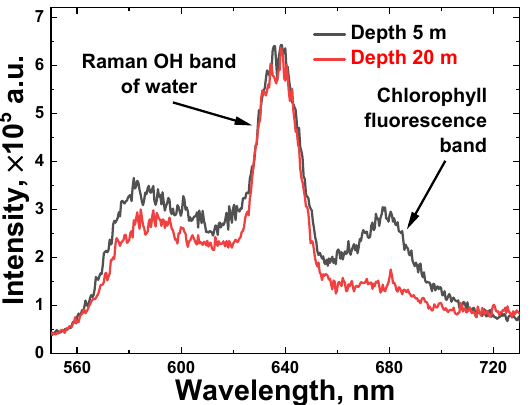
Figure 4. Onboard measured LiDAR raw spectra of water samples taken at station A from 5 and 20 m depths (black and red line, respectively).